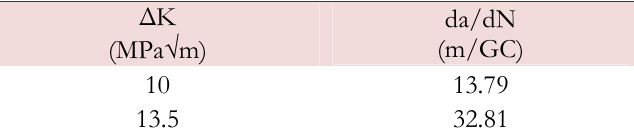
Table 7: Crack growth rates computed using the procedure IV.